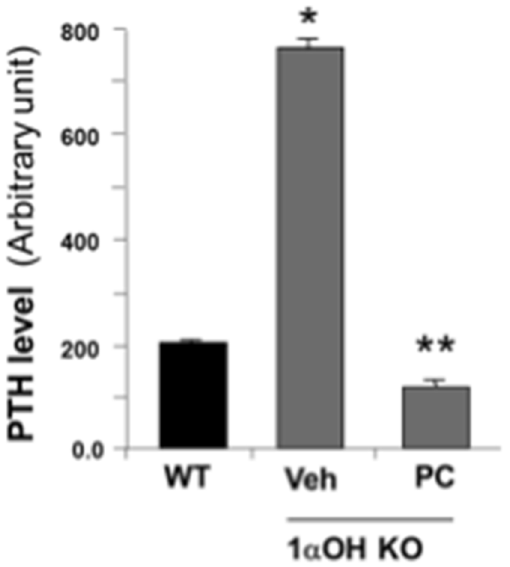
Figure 7. Paricalcitol restore the parathyroid hormone in 1 a - OHase 2 / 2 mice this model. PTH level in 1 a -OHase 2 / 2 mice with or without PC treatment. *, p , 0.05 compared to WT. **, p , 0.05 compared to vehicle.